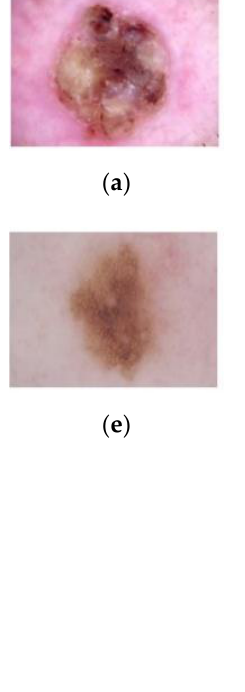
9 of 16 Table 2. Segmentation results of benchmark methods over the Test set (600 images). The results obtained with the SegNet neural network have also been included to facilitate the comparison. Ref.